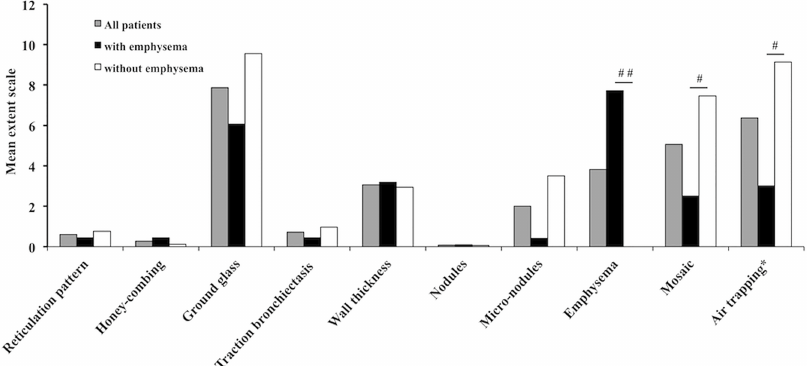
Fig 2. HRCT findings in patients with active FL. Mean of the individualsum of the extent scale for each group. The lungs of each patient were evaluatedby lobe. In each lobe, a score of 0 to 4 was given for each of the features, therefore the maximal possiblescore was 20. # p < 0.01 and ## p < 0.0001; * data available for 20